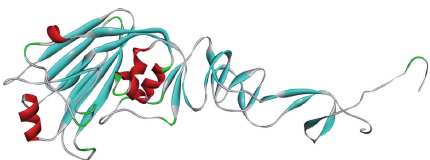
Figure 2: 3D representation of HA best